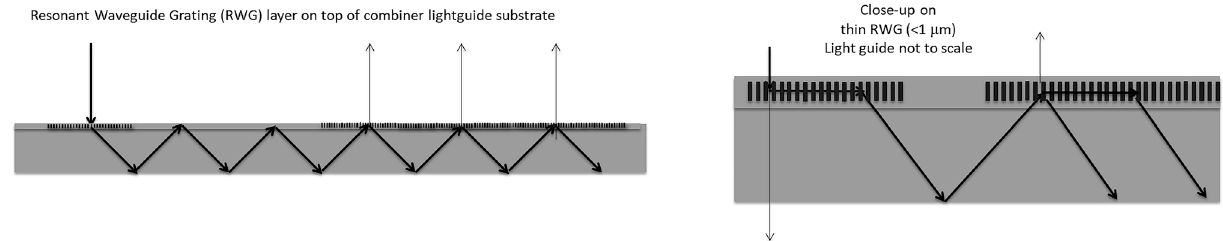
Figure 15: Resonant waveguide gratings as in-couplers and out-couplers on a waveguide